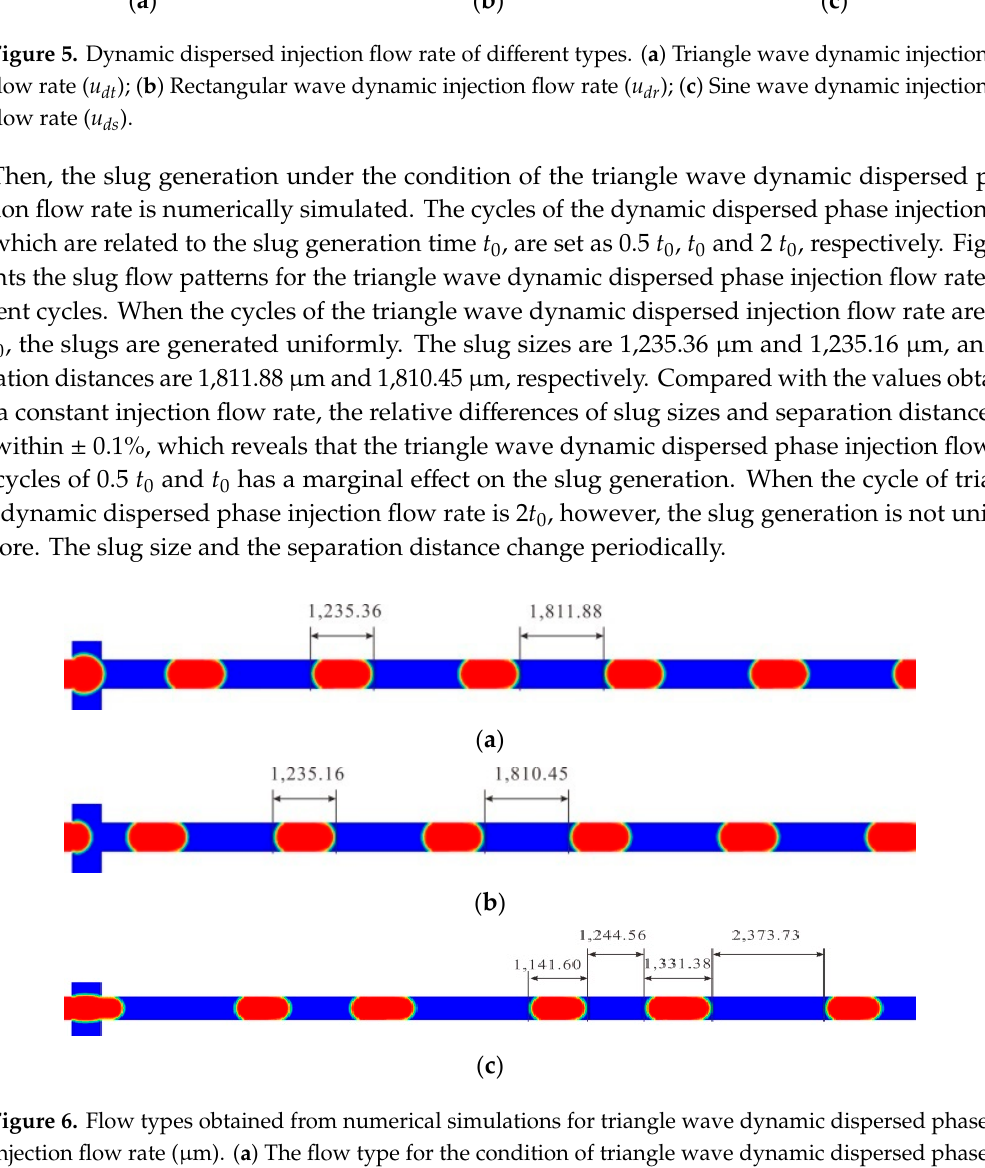
Figure 5. Dynamic dispersed injection flow rate of different types. ( a ) Triangle wave dynamic injection flow rate ( u dt ); ( b ) Rectangular wave dynamic injection flow rate ( u dr ); ( c ) Sine wave dynamic injection flow rate ( u ds ).